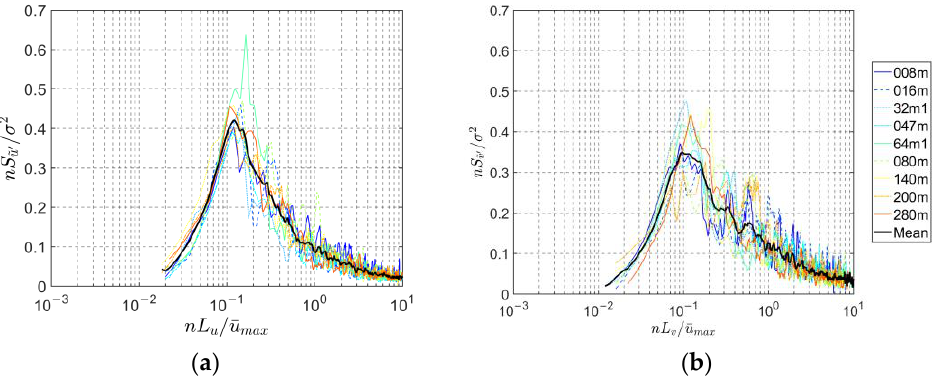
Figure 13. Power spectral density of longitudinal ( a ) and lateral ( b ) reduced turbulent fluctuation.